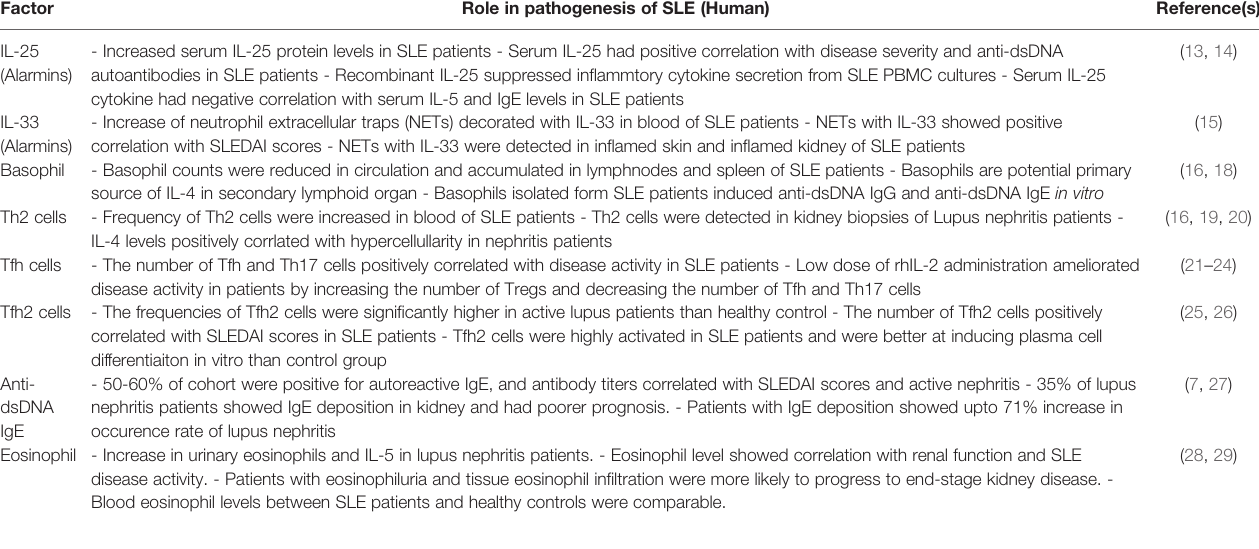
TABLE 1 | Type 2-associated immune response in SLE patients.